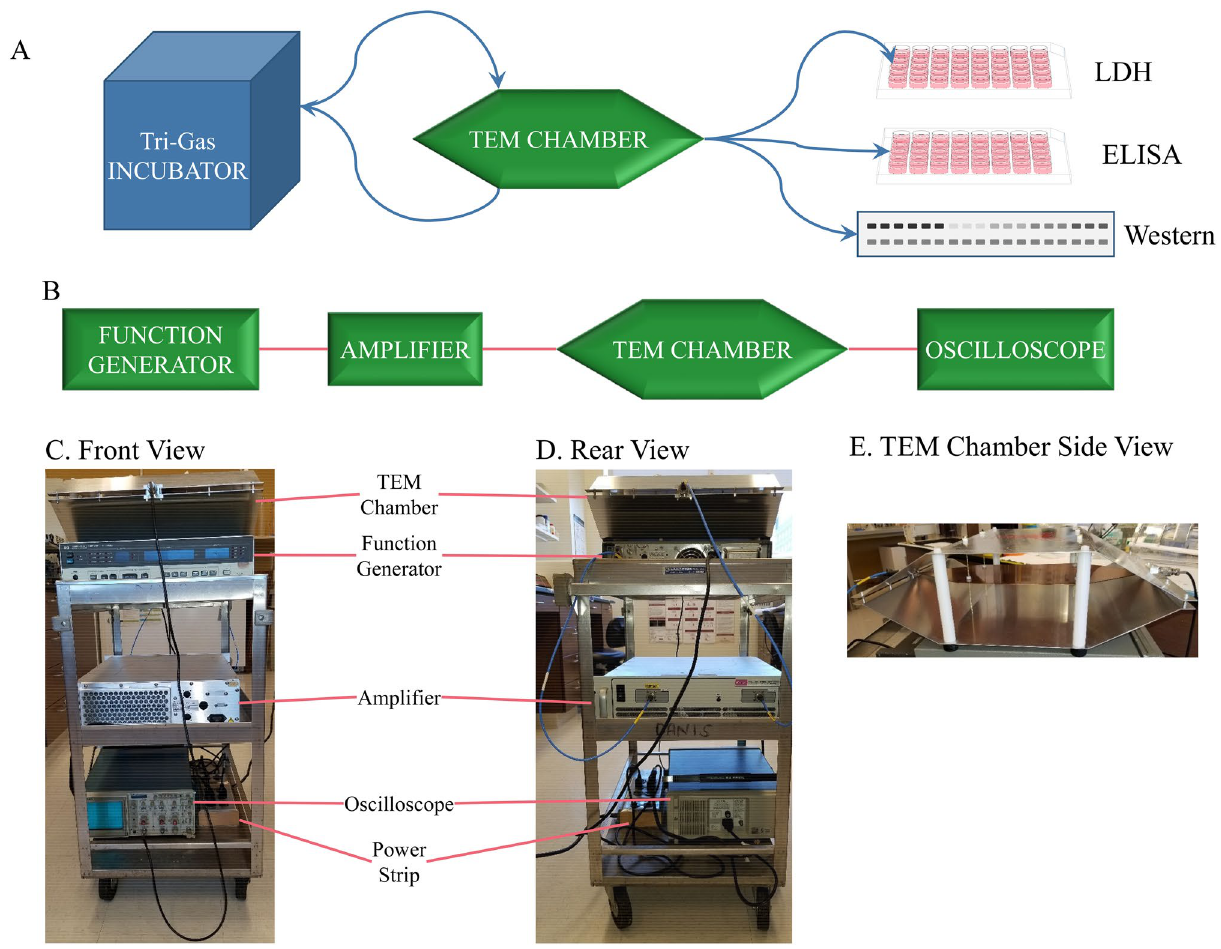
Figure 5. REMFS experiment workflow and apparatus. ( A ) Workflow began with culturing cells in tri-gas incubator, alternating with treatments in TEM chamber. After final treatments, cells were processed and extracts used for analysis by LDH (cell death), ELISA (Aβ) and western blotting (APP). ( B ) Schematic diagram illustrating the source of the electromagnetic fields (function generator). The signal is then sent through an amplifier, then through the TEM chamber. Signal is monitored through the TEM chamber with an oscilloscope. ( C ) Front view photograph of a compact and convenient equipment system. The TEM chamber, being very light, rests upon the function generator. The next lower shelf holds the amplifier. The oscilloscope rests on the bottom shelf. Appropriate cables link each component. Power is supplied by a permanently affixed power strip on the bottom cart shelf. ( D ) Rear view of the compact cart setup. ( E ) Side view of the TEM chamber, showing shelf running across middle.